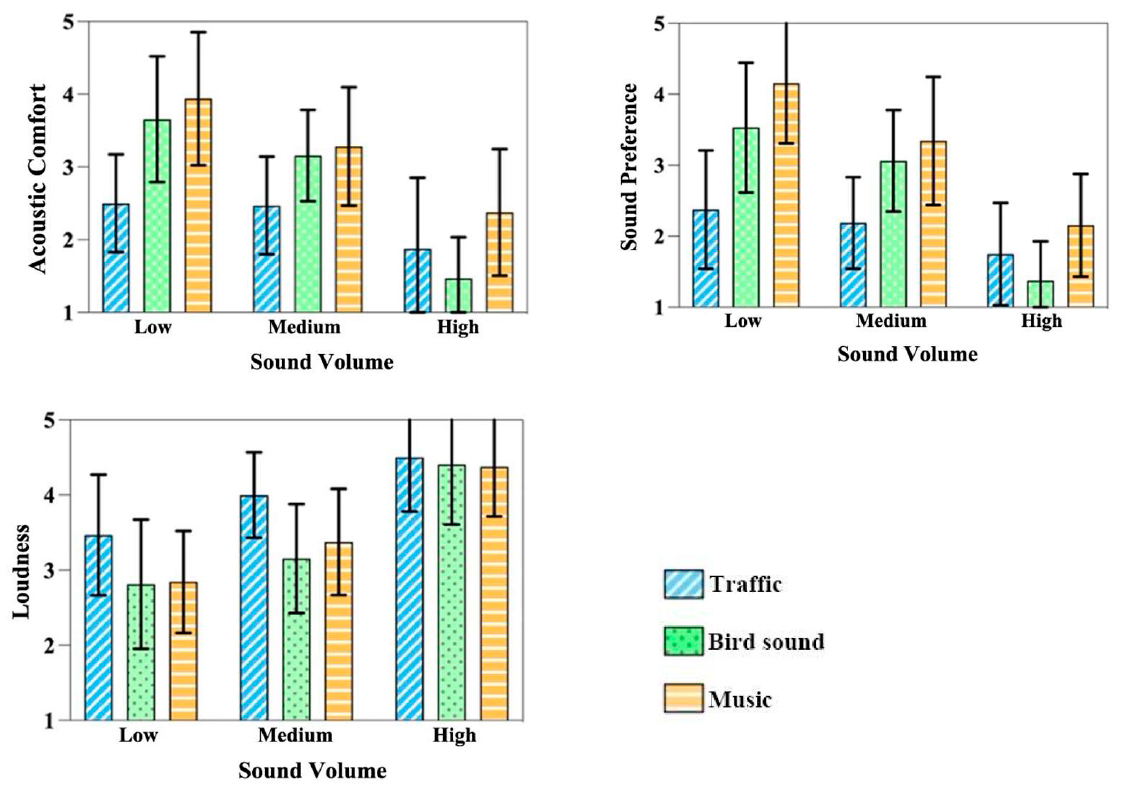
Figure 4. Mean ratings of evaluation indicators under the effect of acoustic factors.